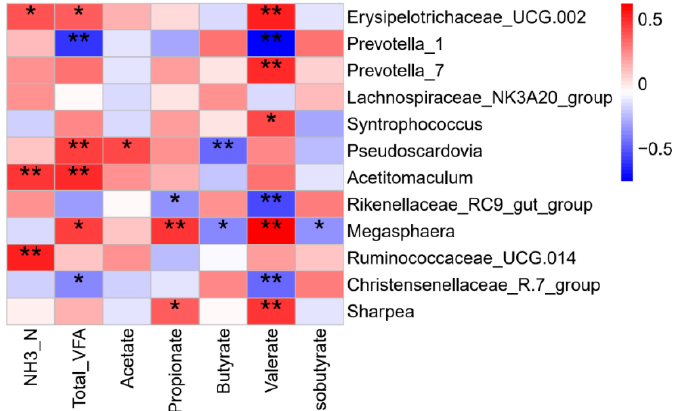
Figure 5. Spearman correlation analysis of ruminal microbiota and rumen fermentation parameters. Color represents the correlation coefficient, with red representing a positive correlation and blue denoting a negative correlation. * p < 0.05 and ** p < 0.01.